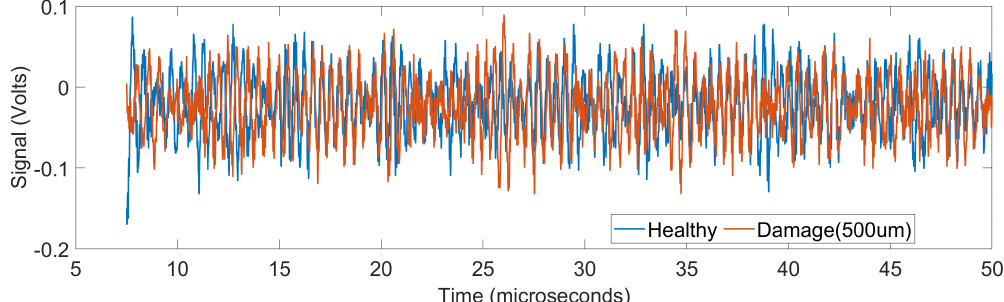
Figure 3. Time-domain signals corresponding to the healthy and damaged samples (damage diameter 500 µ m). Here, the root mean square of the difference between the two signals is 1.024.